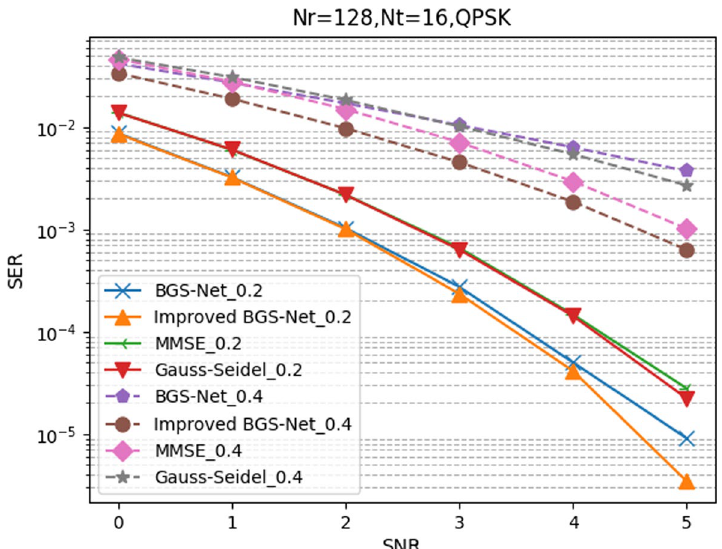
Fig. 25 SER performance comparison of different algorithms for N t = 16,N r = 128 , QPSK, MAUE system with ξ r = 0, ξ t = 0.2 or 0.4